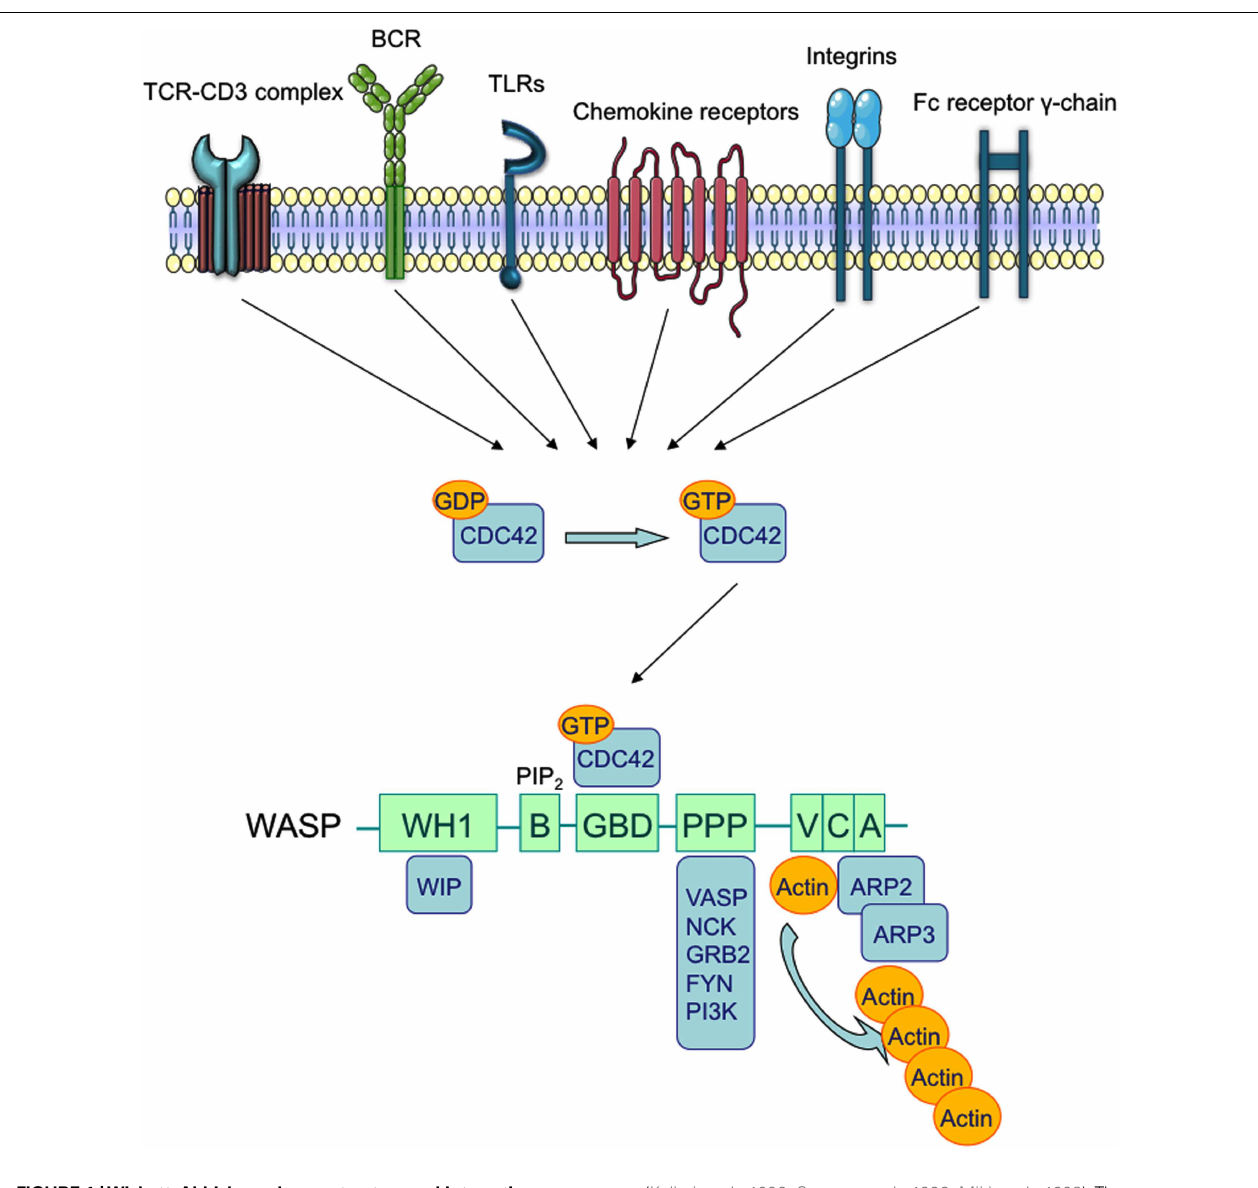
FIGURE 1 |Wiskott–Aldrich syndrome structure and interacting proteins. TCR, BCR, chemokine receptors,TLRs, integrins, and the Fc receptor γ -chain can promote the release of GDP from Rho family GTPases, allowing GTP to bind. In immune cells, the major Rho GTPase is the Cell Division Cycle 42 (CDC42).TheWASP-Homology 1 (WH1) domain mediates the binding toWASP-Interacting Protein (WIP; Ramesh et al., 1997).The Phosphatidylinositol-4,5-bisphosphate (PIP 2 ) links to the Basic (B) domain and stabilizesWASP active form.The binding of the GTPase-Binding Domain (GBD) with CDC42 inducesWASP activation